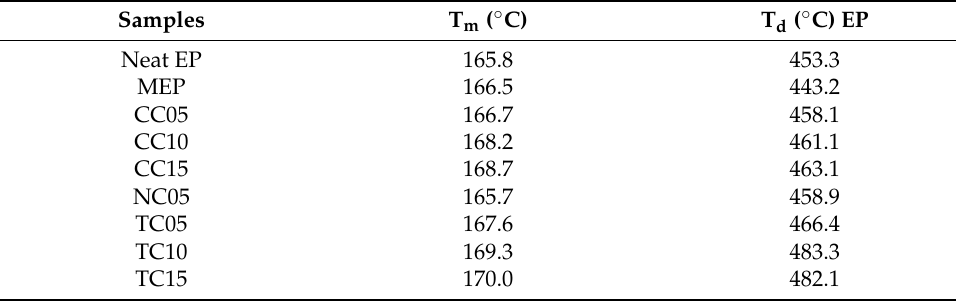
Table 6. Melting and decomposition